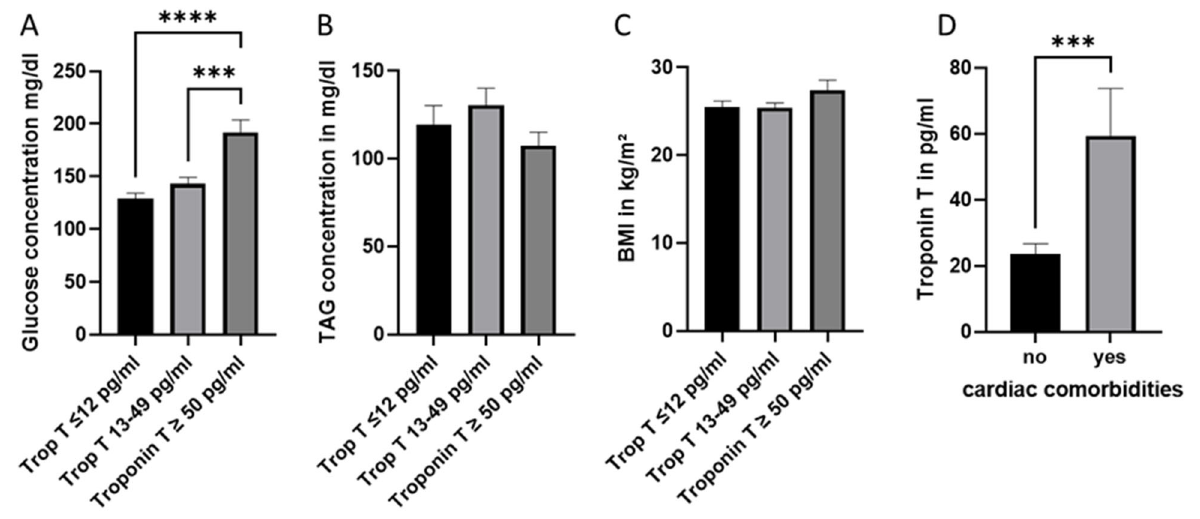
Figure 4. Cardiac risk factors and comorbidities in different groups of polytrauma patients. ( A ) Initial blood glucose concentration in the troponin subgroups ( ≤ 12 pg/mL; between 13–49 pg/mL and ≥ 50 pg/mL). ( B ) Initial triglyceride (TAG) blood concentrations in the troponin patients’ subgroups. ( C ) Body mass index (BMI) in the troponin subgroups. ( D ) Troponin T concentrations in patients with and without cardiac comorbidities. n = 107 patients, *** p ≤ 0.001 and **** p ≤ 0.0001.